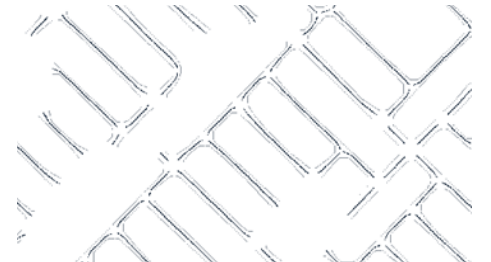
Figure 3 Road sides (gray) and their associated central lines (black)